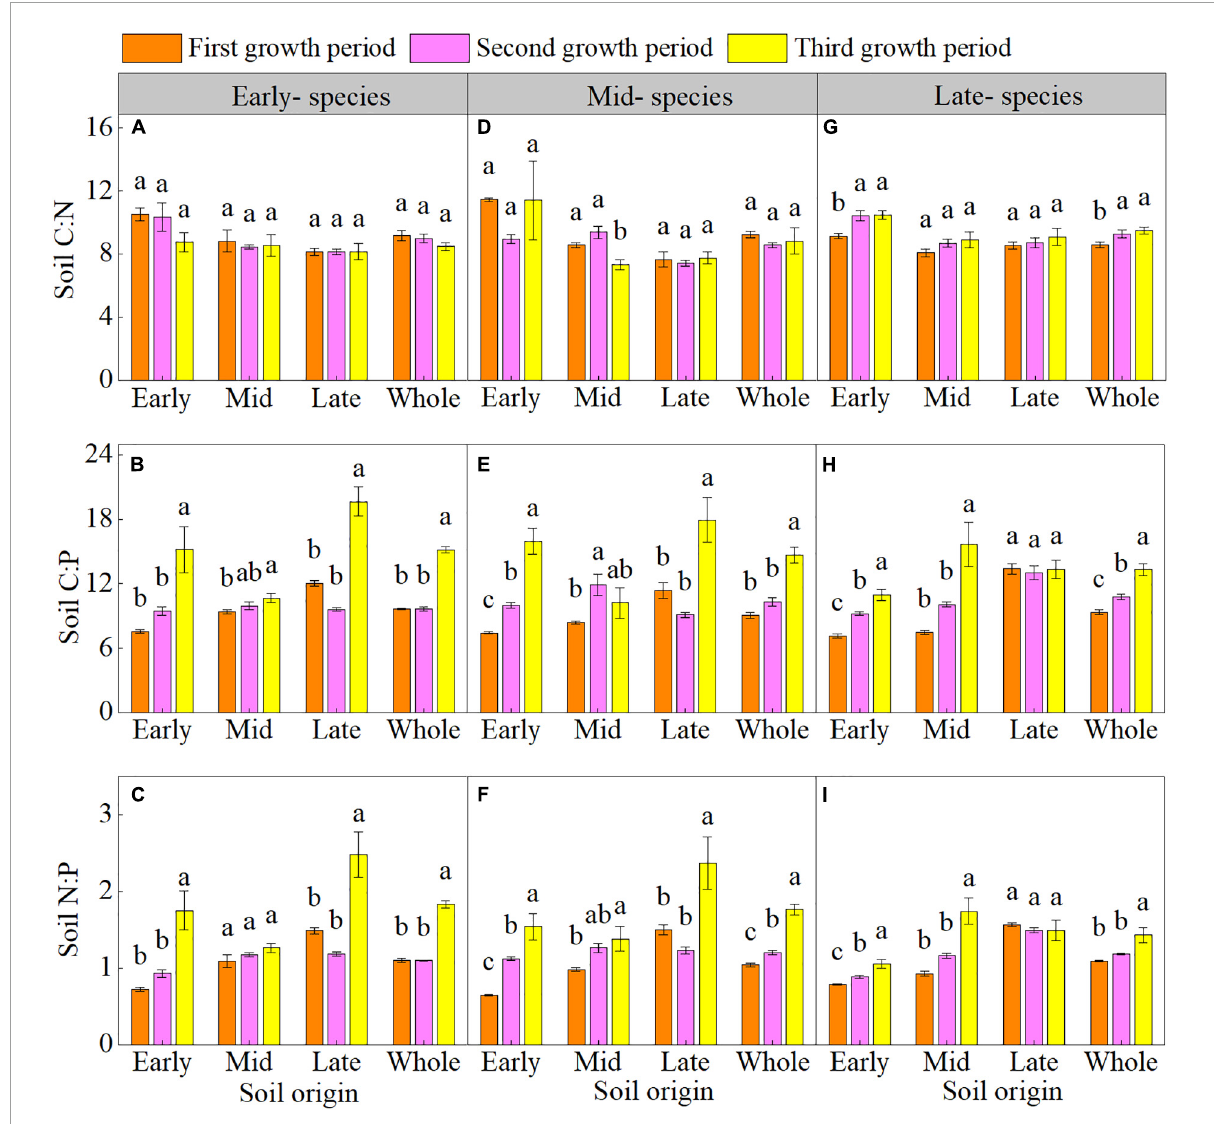
FIGURE2 Mean ( ± SE) ( n = 5) soil carbon-nitrogen-phosphorus stoichiometry (soil C:N, soil C:P, and soil N:P) of early- (A–C) , mid- (D–F) , and late- species (G–I) over the three growth periods. “Whole” is the average soil C:N, soil C:P, and soil N:P of the same species in the three soils. Different lower letters indicate significant differences in mean soil C:N, soil C:P, and soil N:P among the three growth periods based on Duncan’s post-hoc test ( p < 0.05).